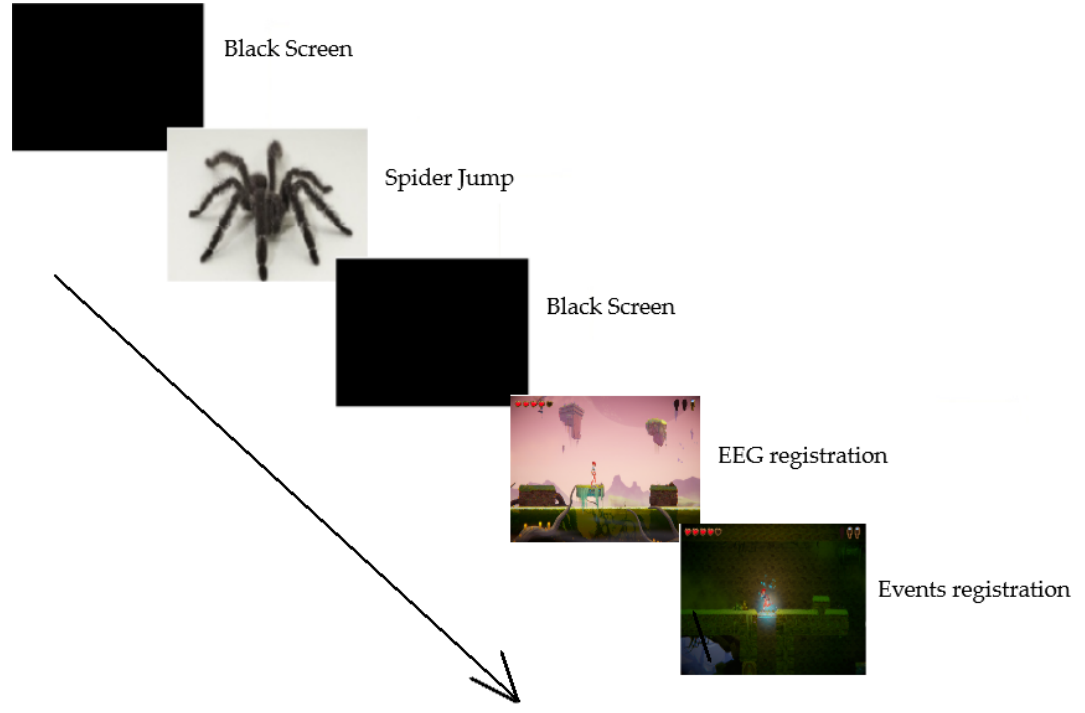
Figure 3. Chronological order of events while playing a computer